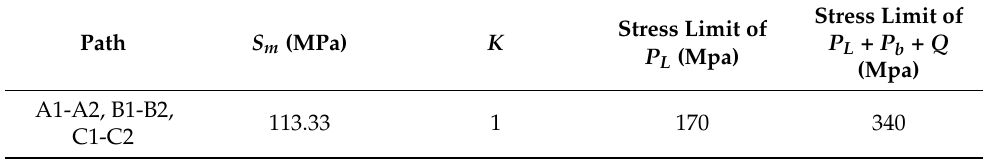
Table 5. Stress intensity evaluation parameters.